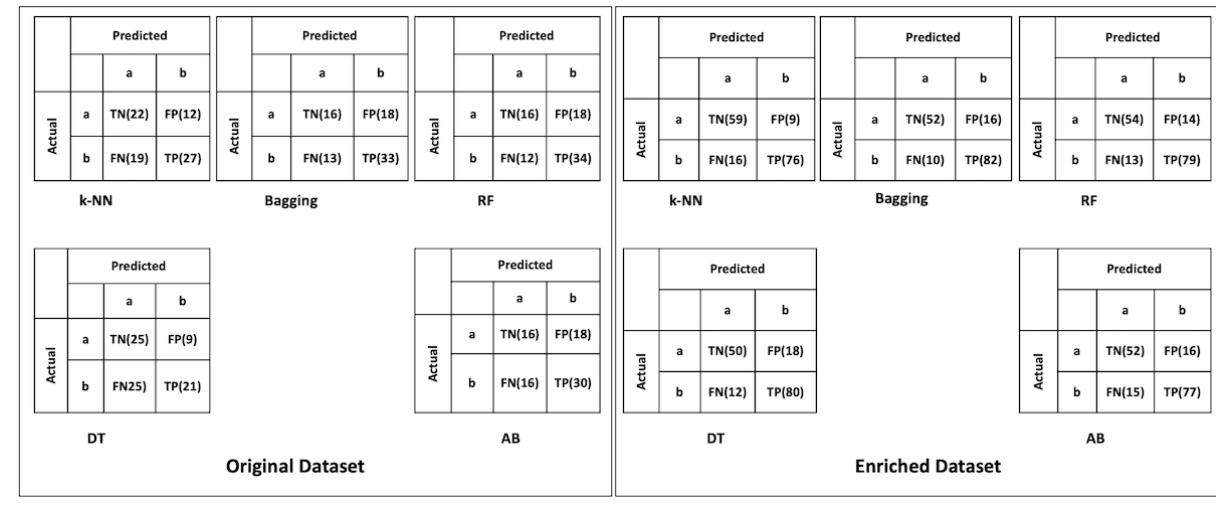
Figure 2. Confusion matrix of applied models before and after data enrichment. AB: AdaBoost; DT: decision tree; FN: false negative; FP: false positive; k-NN: k-nearest neighbor; RF: random forest; TN: true negative; TP: true positive.